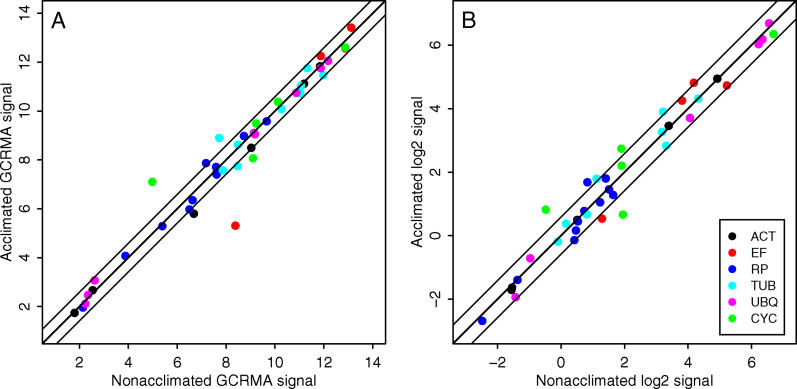
Comparison of Housekeeping Gene log2 Signal between Nonacclimated and 14 d Cold Acclimated Arabidopsis
Data for the ATH1 (A) and MWG (B) arrays are shown. Genes annotated as actins (ACT), elongation factors (EF), DNA-dependent RNA polymerases (RP), tubulins (TUB), poly-ubiquitins (UBQ), and cytosolic cyclophilins (CYC) were used. Genes used are listed in Table S7.